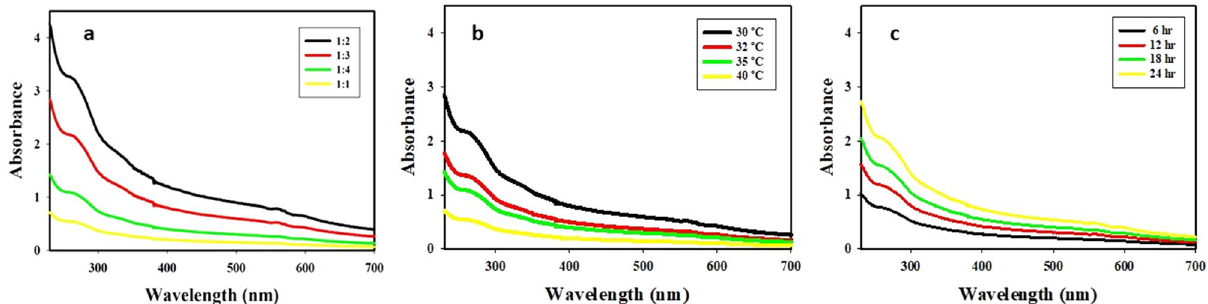
Figure 1. Optimization for B-SeNPs synthesis ( a ) for sodium selenite and cell extract concentration ratio ( b ) for temperature ( c ) reaction time.